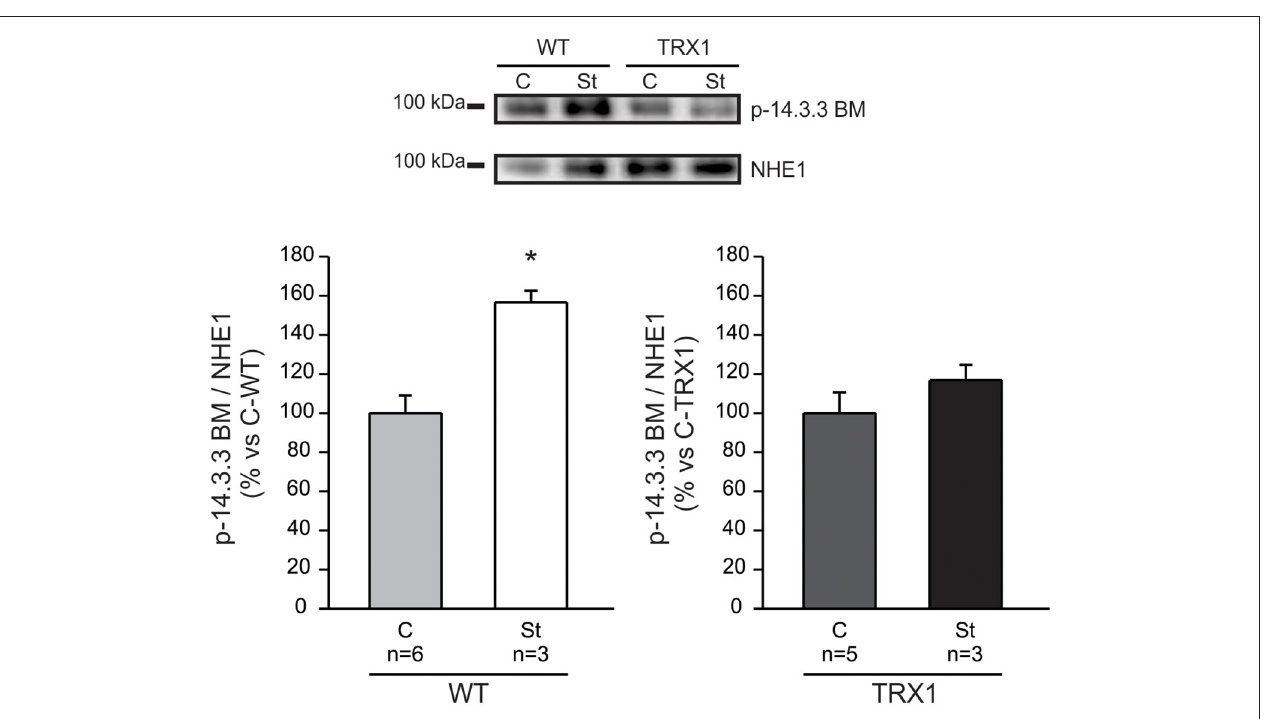
FIGURE 2 | NHE1 phosphorylation after stretch. Myocardial stretch promoted a significant increase in NHE1 phosphorylation in WT mice (“St-WT”) compared to non-stretched controls (“C-WT”), as shown in the original immunoblot (upper panel) and in the averaged results of the lower left panel. Interestingly, the stretch of muscles overexpressing TRX1 (“St-TRX1”) did not show significant changes in NHE1 phosphorylation compared to its corresponding non-stretched controls (“C-TRX1”), as shown in the immunoblot (upper panel), and in the averaged results (lower right panel). *Indicates p < 0.05 vs.